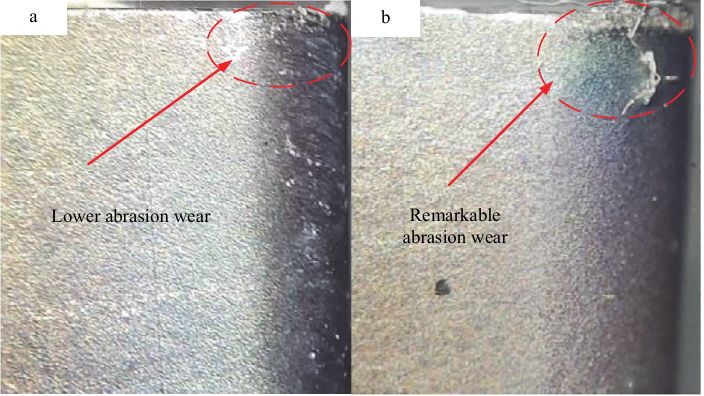
Figure 10. Image of tool wear for ( a ) LCO2 as a cryogenic cutting fluid and ( b ) wet machining [58]. Obikawa et al. [64] also proposed processing Inconel 718 with microliter lubrication, which shortens the coolant delivery time to the workpiece, protects the tool, and im ‐ proves machining efficiency. A study by Thamizhmanii and Hasan [65] showed that when the coolant supply during processing was 37.5 mL/h the surface finish of the pro ‐ cessed workpiece was relatively good. The results showed that the surface finish of the workpiece after machining was affected by the amount of coolant supply. Vernaza ‐ Pena